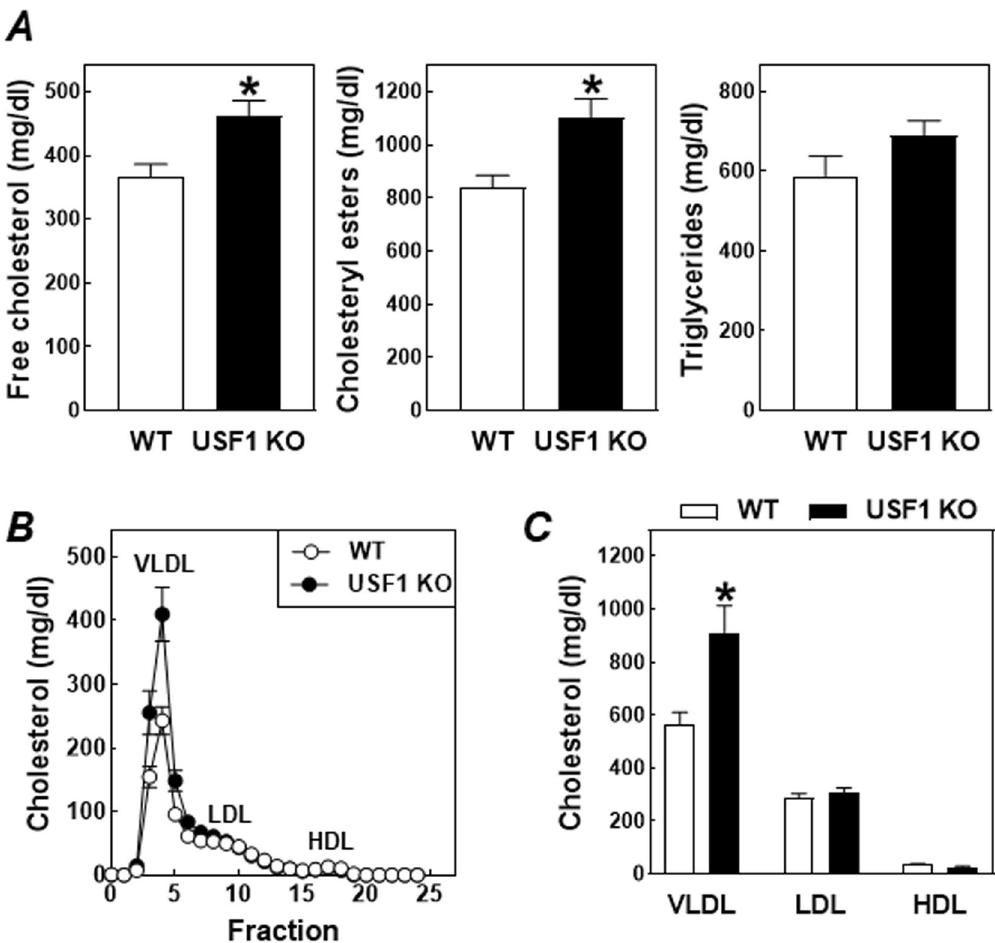
Figure 6. Plasma levels of free cholesterol, cholesteryl esters and triglycerides ( A ) and the distribution of total cholesterol over the different lipoproteins ( B , C ) in LDL receptor knockout mice transplanted with bone marrow from USF1 knockout (USF1 KO) mice or their wild-type (WT) littermate controls. Fractions 1–6 represent VLDL, fractions 7–13 LDL, and fractions 14–22 HDL. Data represent the means ± SEM of respectively 11 WT and 16 USF1 KO bone marrow recipients. * P < 0.05 versus